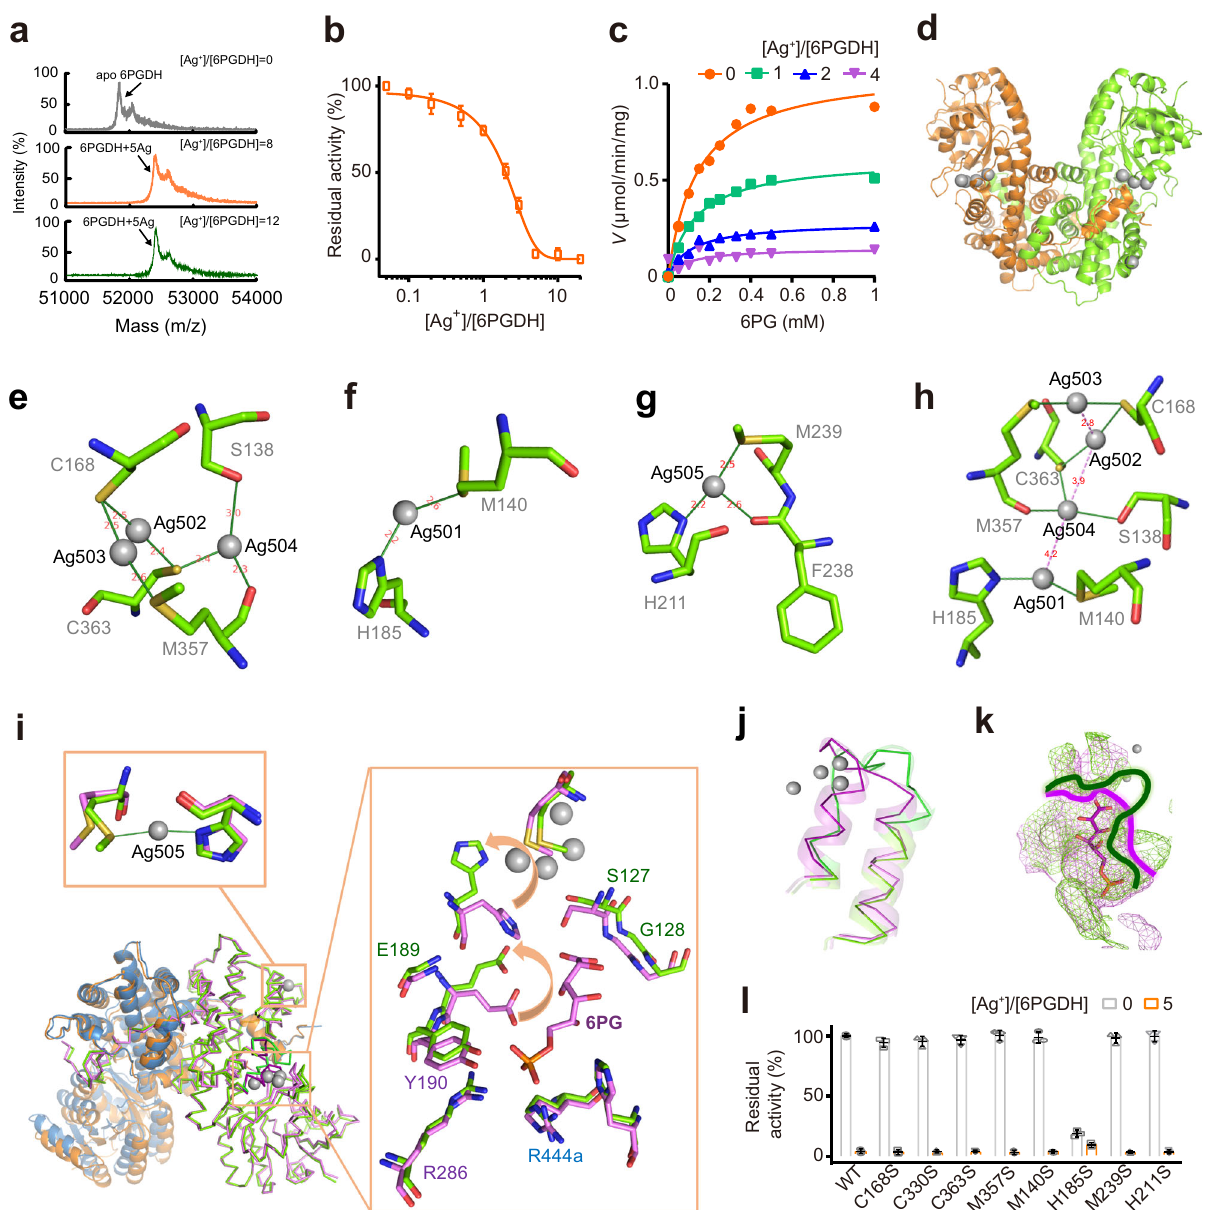
Fig. 3 Molecular mechanism underlying Ag + inhibition of 6PGDH activity. a MALDI-TOF mass spectra of apo-6PGDH and 6PGDH after incubation with 8 and 12 eq. of Ag + . b Dose-dependent inhibition of 6PGDH by Ag + ( n = 3). c 6PGDH activity in the presence of different amount of Ag + . 6PGDH activity is de fi ned as μ mol/min/mg ( n = 3). d Overall structure of Ag-bound 6PGDH. e – g Crystallographic analysis of the binding mode of Ag + at different coordination sites of 6PGDH. h Silver cluster composed by four adjacent Ag ions. i Superimposition of Ag-bound 6PGDH (green) to substrate-bound 6PGDH (violet). j Binding of Ag501-504 to 6PGDH signi fi cantly changed the secondary structure of residues of 352 – 371. Ag-bound 6PGDH and substrate- bound 6PGDH are presented in green and violet cartoon, respectively. k The 6PG binding pocket is apparently morphed in Ag-bound 6PGDH. Ag-bound 6PGDH and substrate-bound 6PGDH are presented in green and violet mesh, respectively. d – k The binding sites of Ag + in 6PGDH with Ag + shown as gray spheres. l Normalized residual activity of WT 6PGDH and 6PGDH mutants in the absence and presence of 5 eq. of Ag + ( n = 3). Mean value of three independent replicates is shown and error bars indicate ±SEM ( b , l